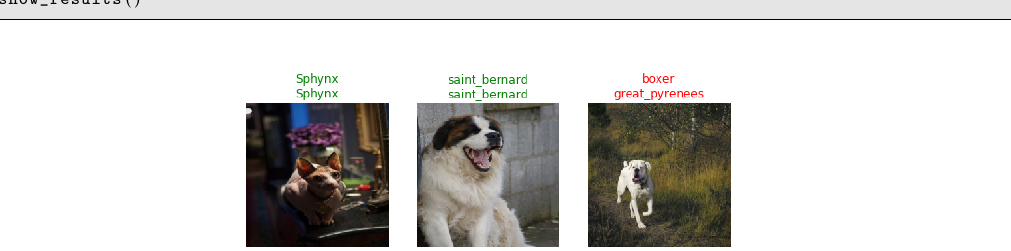
Figure 3. A Learner knows from the data and the model type how to represent the results. It can even highlight model errors (here predicted class at bottom and actual at